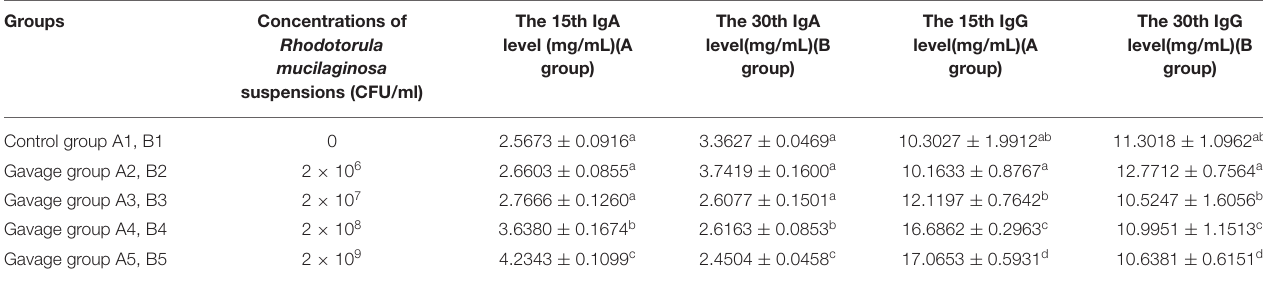
TABLE 4 | Effects of R. mucilaginosa on IgA and IgG content in mouse serum.